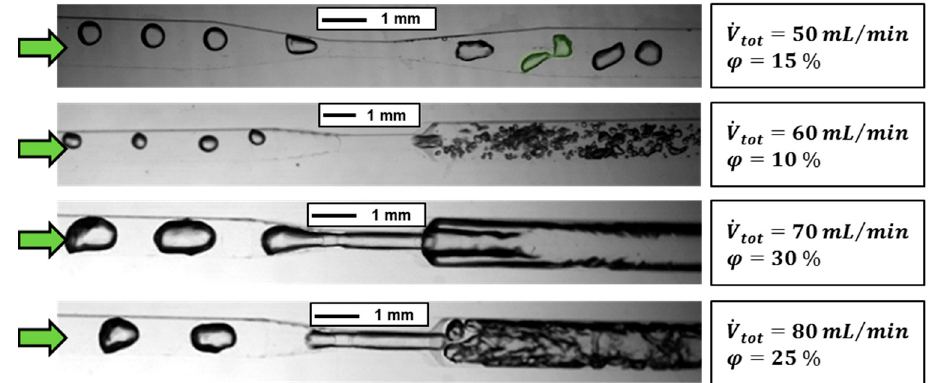
Figure 9. Observed bubble breakup and flow regimes behind the micronozzle. The arrow marks the direction of flow. Process parameters are given next to the respective picture. From top to bottom: Laminar bubble breakup with We ≈ 5 and Re ≈ 1660, turbulent breakup with We ≈ 7 and Re ≈ 2300, annular flow with We ≈ 10 and Re ≈ 2330, disturbed annular flow with We ≈ 10 and Re ≈ 2660. The bubble, which is about to break up, is highlighted in the laminar regime in Figure